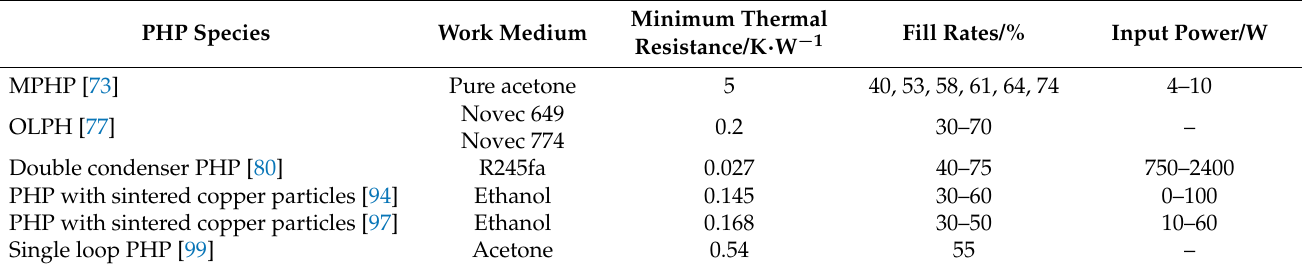
Table 2. The heat transfer performance of PHP